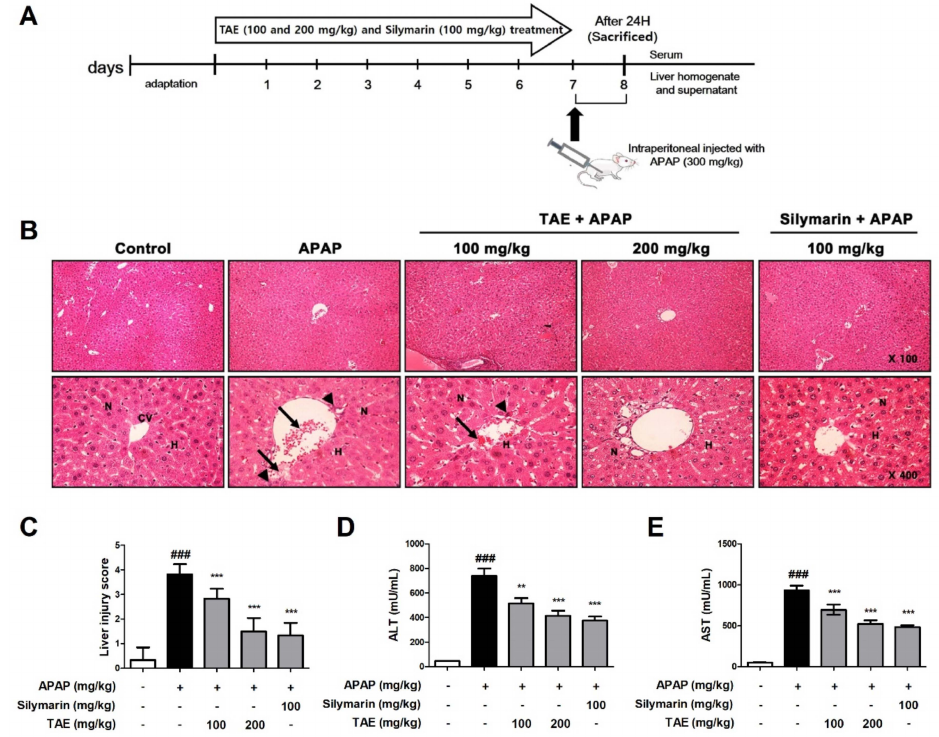
Figure 2. Effect of ethanolic Triticum aestivum sprout extract on N -acetyl-para-aminophenol